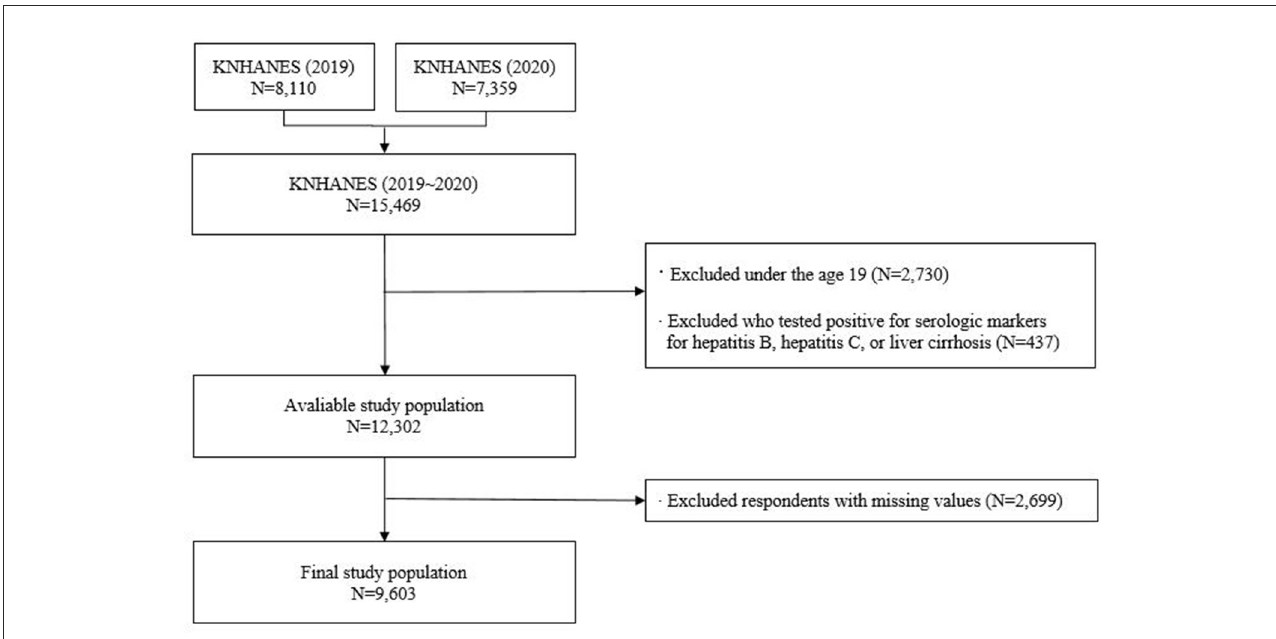
FIGURE1 Flowchart of the study participants showing the inclusion and